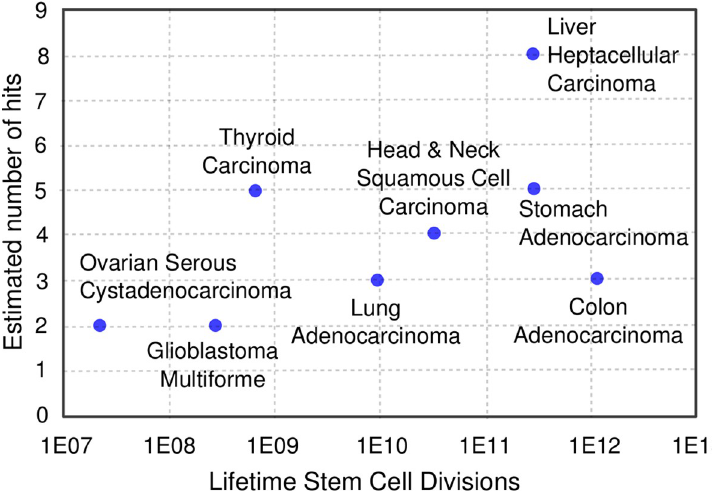
Fig 5. Estimated number of hits are moderately correlated to lifetime stem cell division. Pearson’s linear coefficient = 0.522, suggesting that number of hits may depend on cellular growth characteristics of individual tissues. However, the 95% confidence interval = -0.29–0.90, indicating that the relationship may be coincidental. Estimates for lifetime stem cell divisions were from S1 Table of Ref.